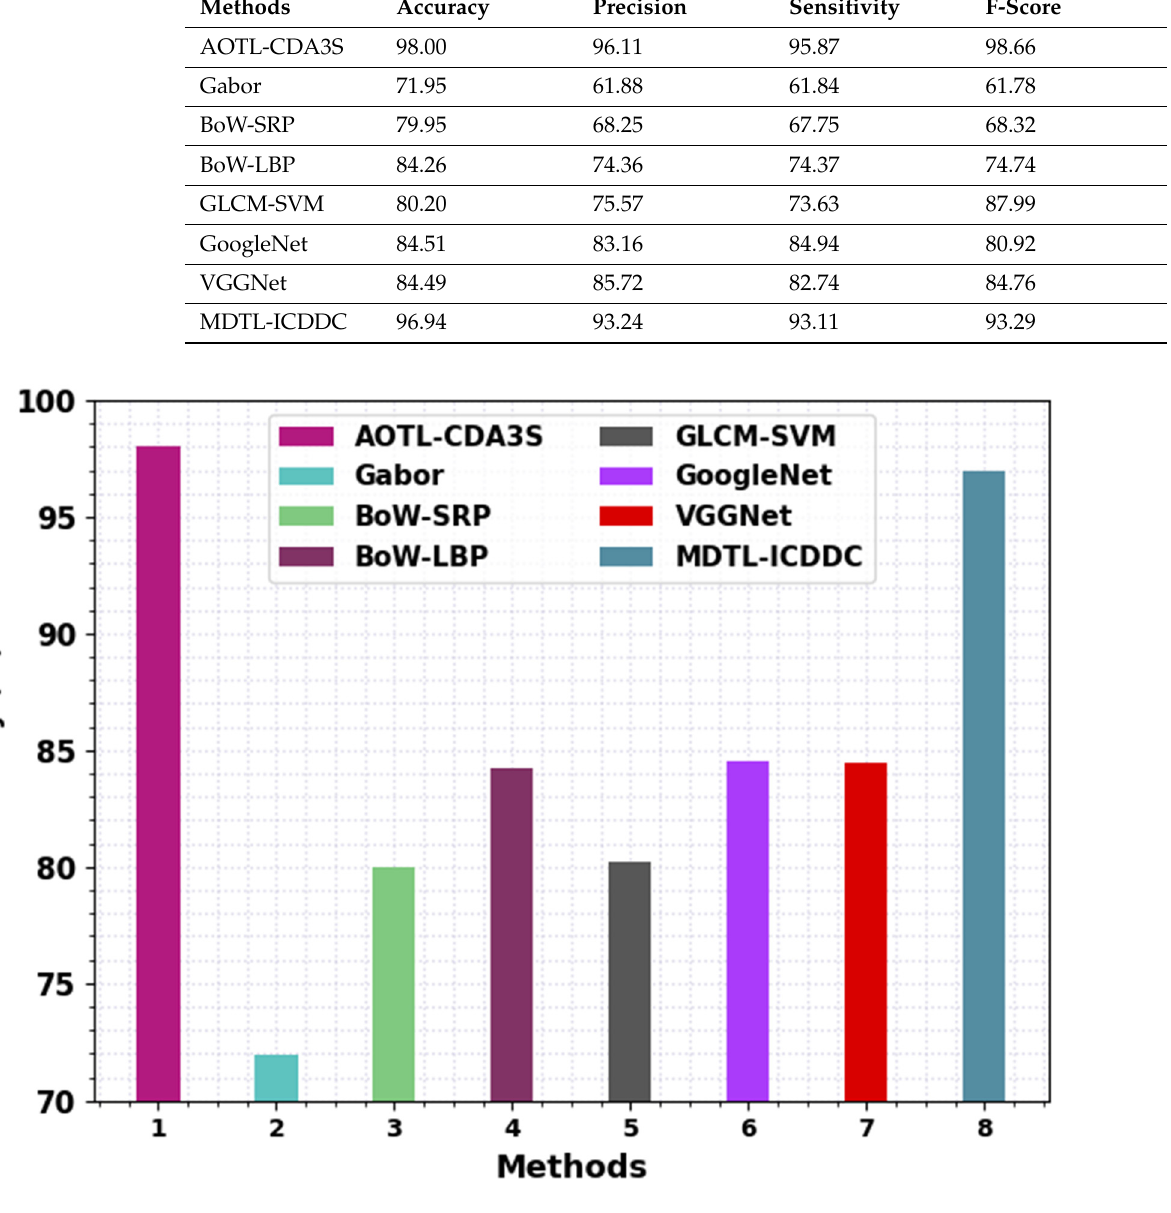
Figure 11. Comparative analysis of the AOTL-CDA3S system with recent approaches.